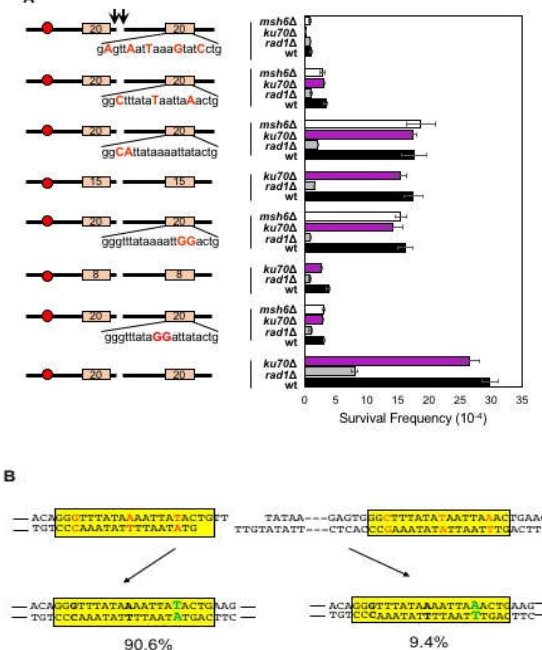
Figure 4. The e ff ect of mismatches on microhomology selection for MMEJ. ( A ) Left: A diagram of MMEJ reporters with imperfect microhomologies carrying di ff erent numbers and positions of mismatches. The locations of HO cut site (arrow), microhomology (orange boxes), and centromere (red circles) are shown. The size of microhomology is shown in number (bp) inside the microhomology. The sequence of microhomology and the position of mismatch (highlighted in red) are shown. Right: Graph showing survival frequency ± s.d. in wild type (WT), RAD1 ∆ (MMEJ deficient mutant), ku70 ∆ (C-NHEJ deficient mutant), and msh6 ∆ (mismatch repair deficient mutant). Survival frequency was calculated as described in Figure 1. The results are the average of three independent experiments. ( B ) Two di ff erent ways (highlighted in green characters) mismatches (shown in red) in microhomology were repaired. The corrected bases are shown in bold characters. The microhomology is shown in yellow boxes. Analyses of 94 MMEJ products showed strong bias to one type over the other. The percentage of repair product type among total MMEJ repair events was calculated based on sequencing of the repair junctions from the Ura- survivors after HO